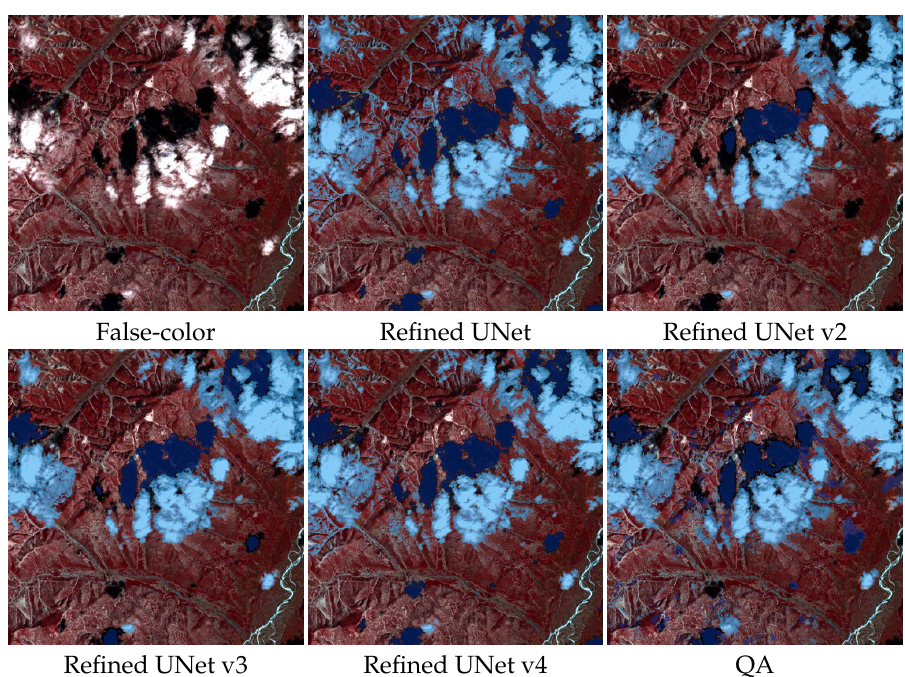
Figure 1. Illustration of qualitative differences between the Refined UNet series [1,2,7]. False-color and QA denote the false-color (Bands 5 NIR, 4 Red, and 3 Green) and label reference images. Refined UNet v4 is visually comparable to Refined UNet, in terms of edge-precise segmentation of cloud and shadow regions. In addition, v4 is able to retrieve more potential shadow regions with ambiguous edges, in comparison with v2 and